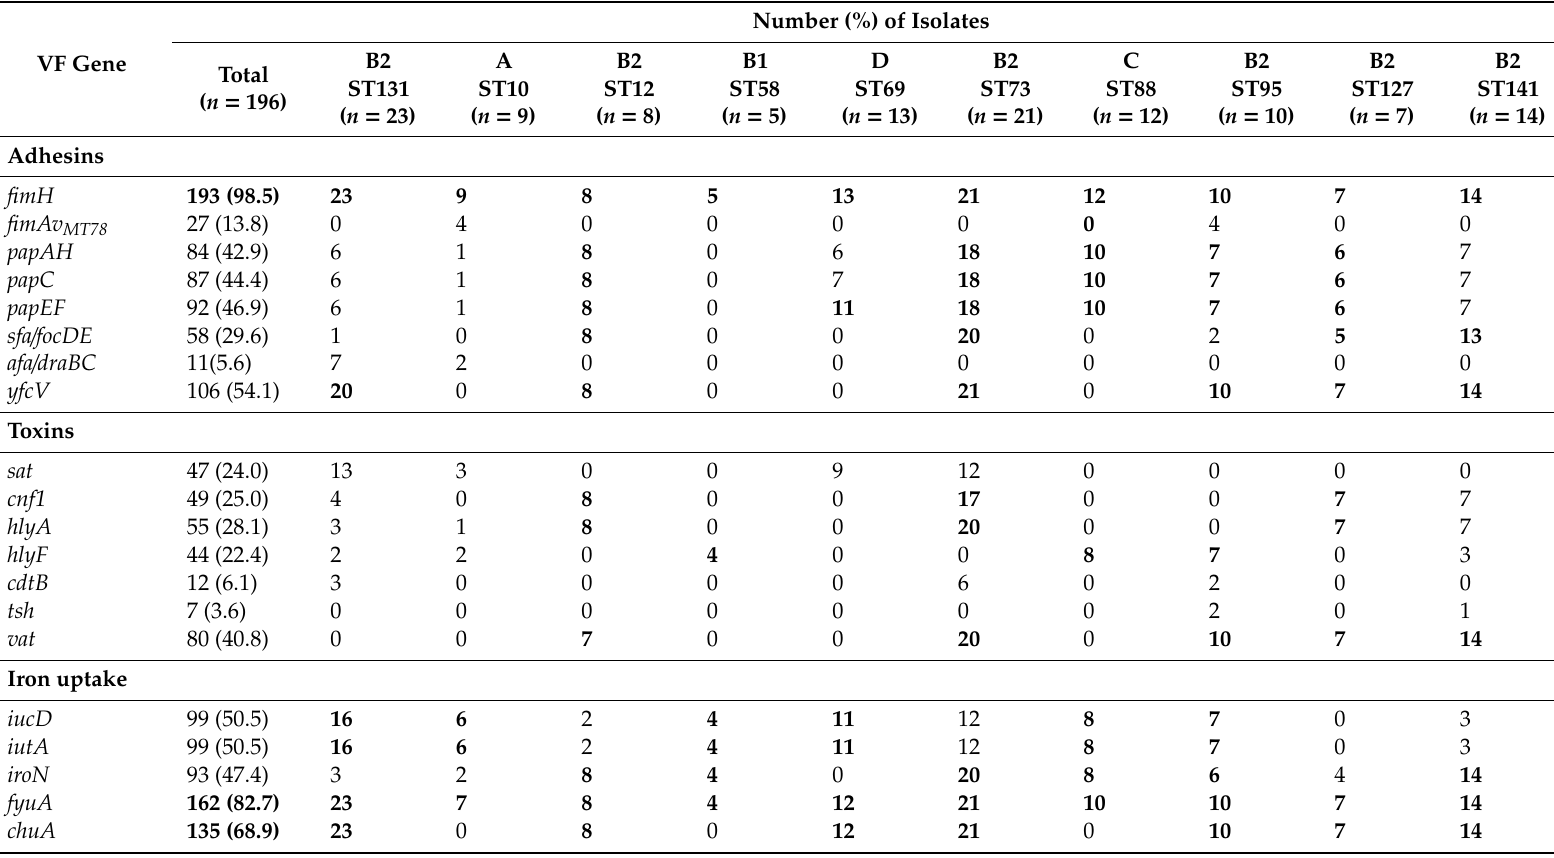
Table 2. Virulence factor (VF)-encoding genes observed from the 196 isolates and the isolates included in the 10 most frequent sequence types.